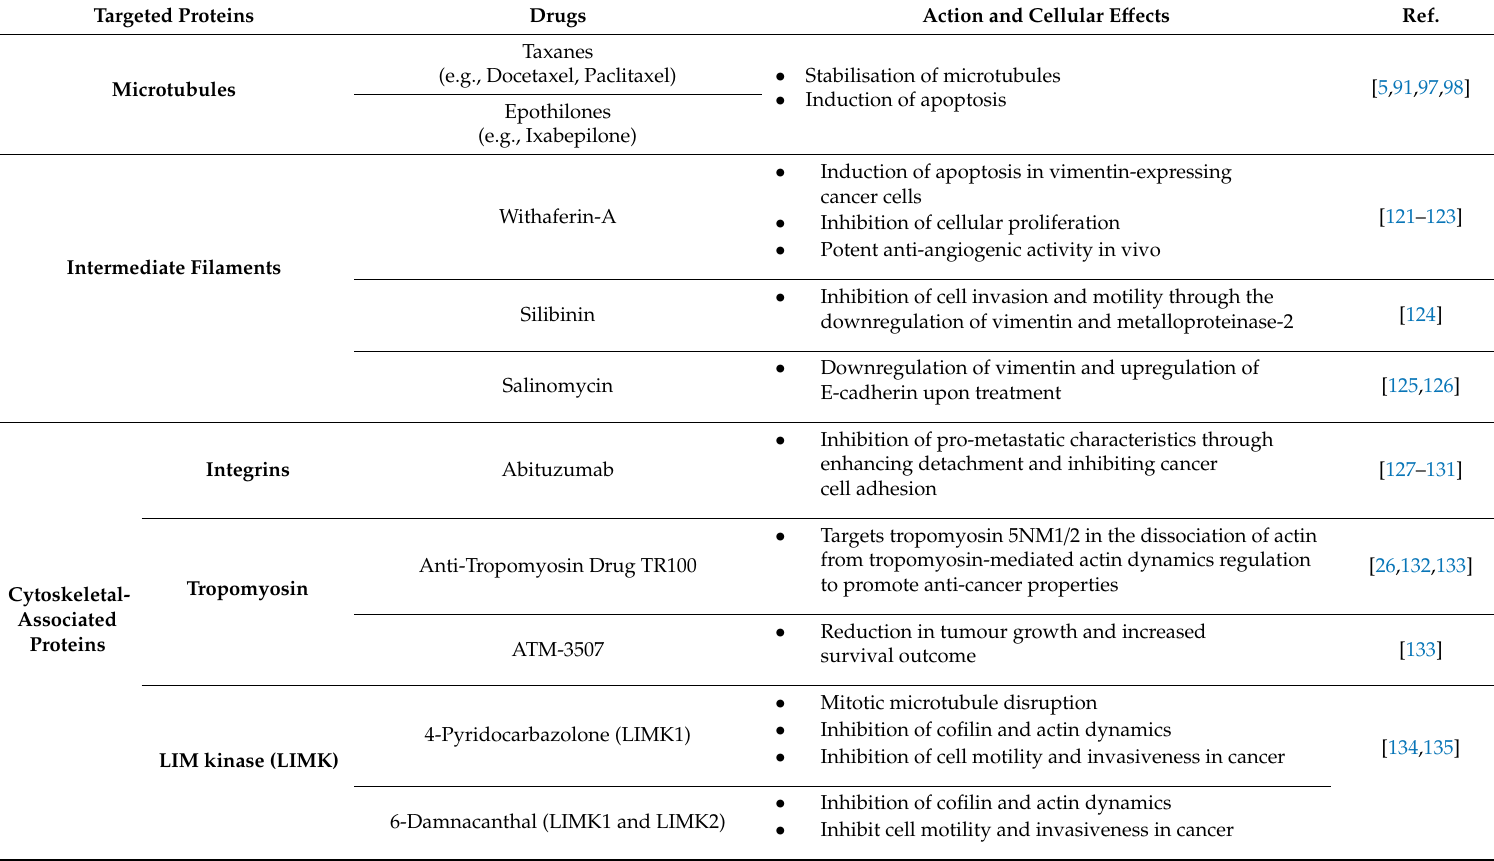
Table 1. Examples of drugs targeting other classes of cytoskeletal molecules and cellular e ff ects. Di ff erent classes of cytoskeletal proteins can be targeted and have the potential to be targeted. These include well known drugs, such as taxanes and epothilones, that target microtubules and less known drugs that target the intermediate filaments. Moreover, the targeting of cytoskeletal associated proteins can also a ff ect cytoskeletal proteins to bring about cellular changes and inhibit cancer